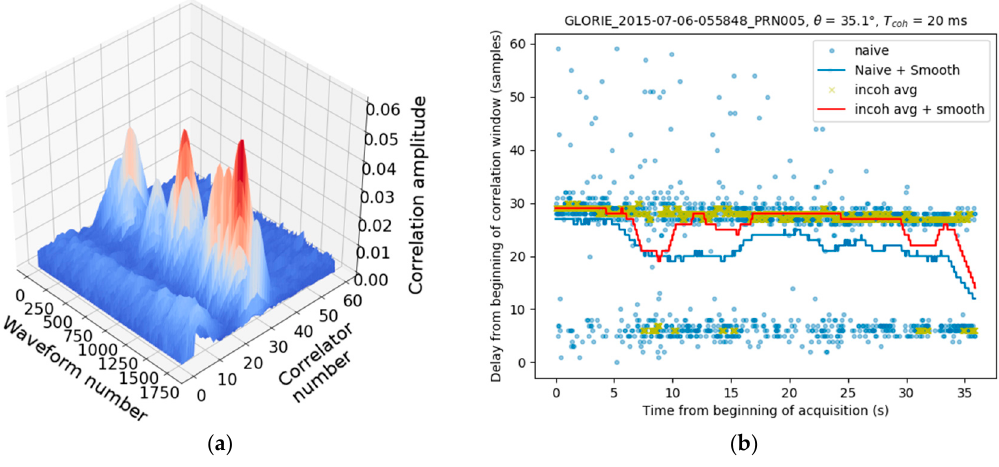
Figure 7. ( a ) Reflected waveform time series in case of strong direct signal contamination; ( b ) Peak detection using methods described before: It can be seen that both the naive and incoherently averaged solution are suffering from the direct signal peaking at five samples from the beginning of the correlation window. In both figures the aircraft height is ~590 m AGL.